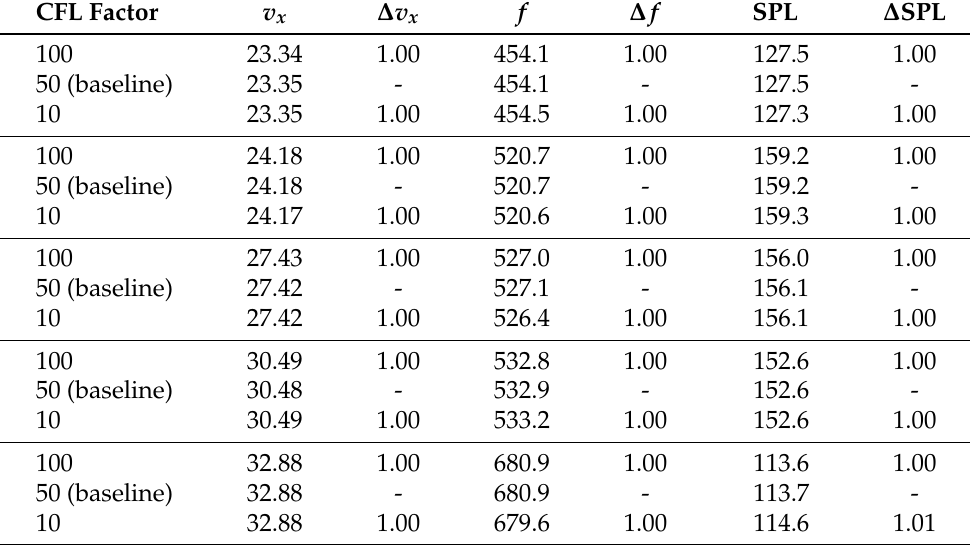
Table 6. Influence of the CFL factor on velocity, shedding frequency, and sound pressure